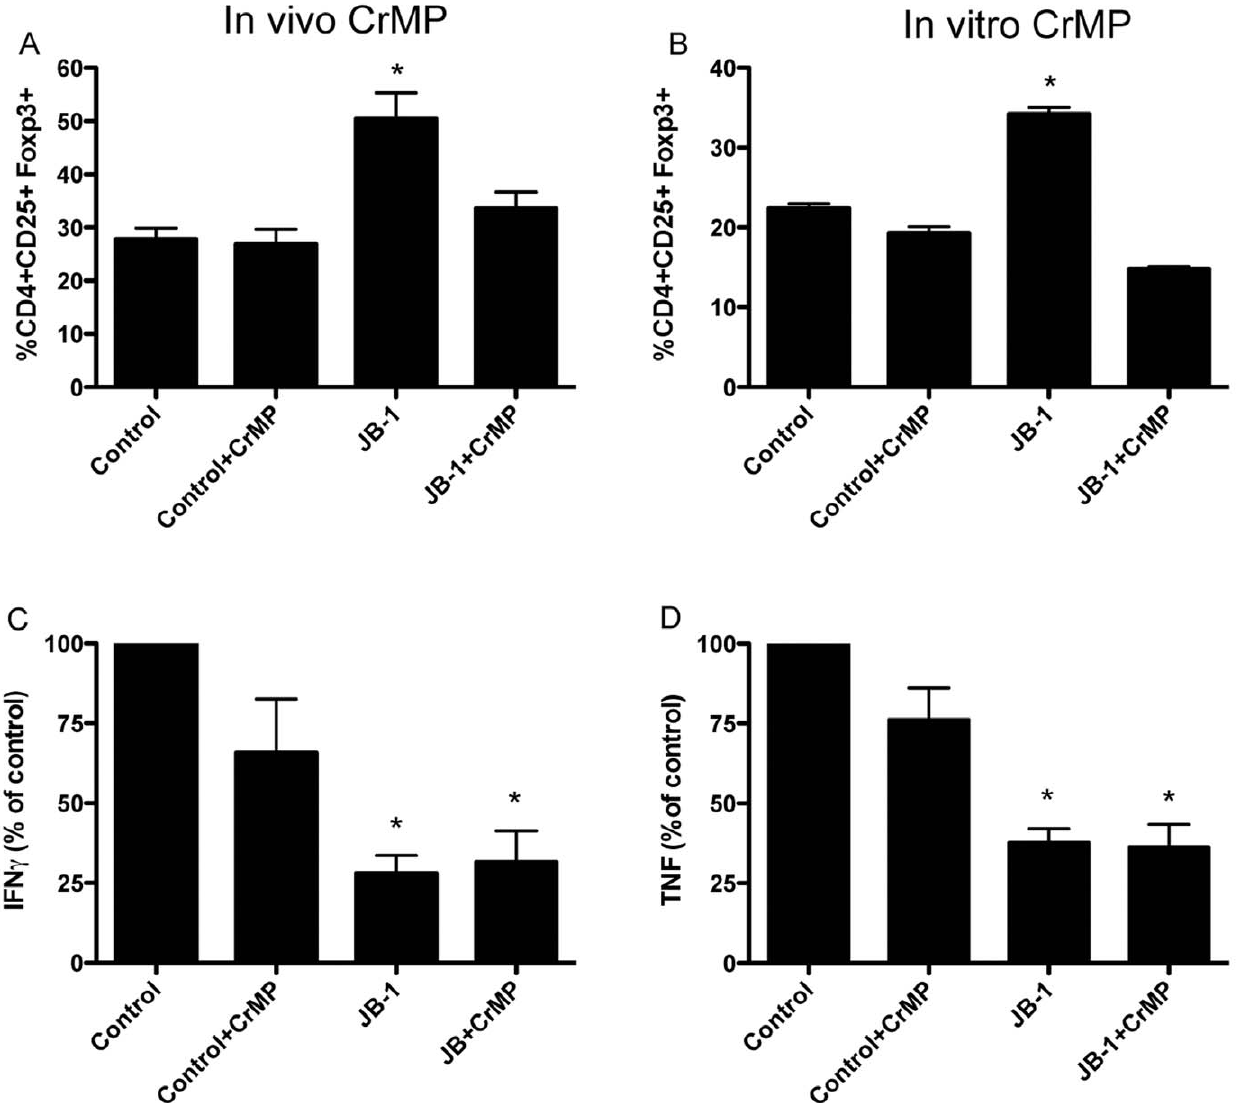
Figure 7. Heme oxygenase-inhibition attenuates Lactobacillus induced foxp3 expression in mesenteric lymph nodes but does not interfere with down-regulation of T cell inflammatory cytokine release. Balb/c mice received i.p. Chromium mesoporpyrin (CrMP) daily for 7 days. Mice were gavaged with JB-1 or vehicle for the last 5 days of experiment and mesenteric lymph nodes were harvested. (A) Single cell suspensions of mesenteric lymph nodes stained for CD4, CD25 and Foxp3 and analyzed by FACS. (B) Isolated mesenteric CD11c + DC were co- cultured with L. rhamnosus JB-1 at a ratio of 10:1/bacteria:DC, for 2 h at 37 u C and incubated in the presence or absence of CrMP (5 m M) with purified CD4 + T cells from DO11.10 transgenic mice for 5 days stained for CD4, CD25 and Foxp3 and analyzed by FACS. (C&D) Single cell suspensions of mesenteric lymph nodes were stimulated by antibodies against CD3/CD28 for 48 hr and the supernatants analyzed for cytokine production. Release of TNF and IFN c , relative to vehicle control (TNF 398 6 49.2 pg/ml, IFN c 592 6 105 pg/ml) is depicted. Data is presented as mean values 6 SEM n=5, *p , 0.05 compared to control values.